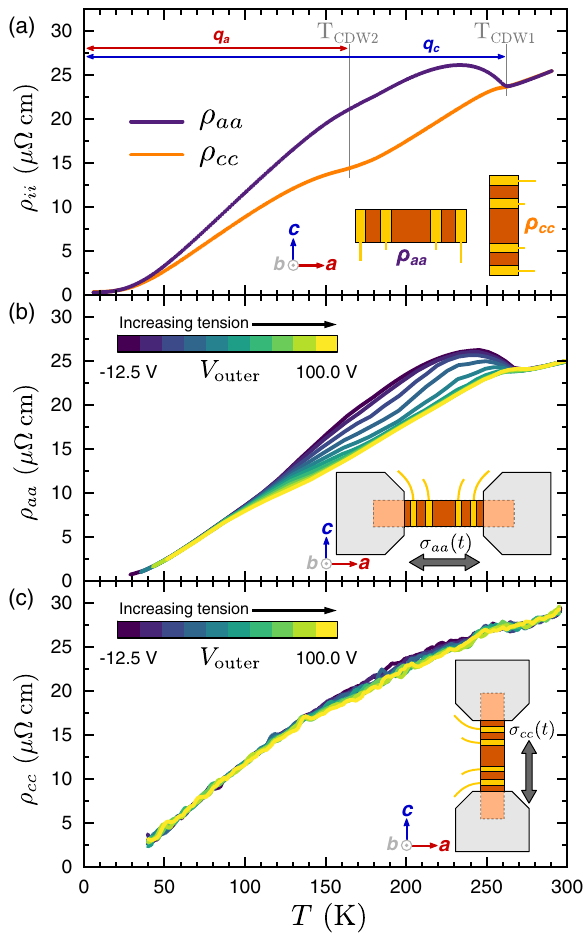
FIG. 6. In-plane resistivity components of ErTe 3 as a function of temperature and strain. (a) Freestanding resistivity components of ErTe 3 . Resistivity along the a axis increases more strongly upon entering the q c state due to the curvature of the gapped region of the Fermi surface [35]. (b) a -axis resistivity of ErTe 3 under a -axis stress, as a function of temperature and PZT voltage. Negative and low voltages behave similarly to the freestanding case for ρ , but crosses over to resemble freestanding ρ as the aa cc tension increases. (c) c -axis resistivity under c -axis stress, which does not demonstrate any switching behavior.